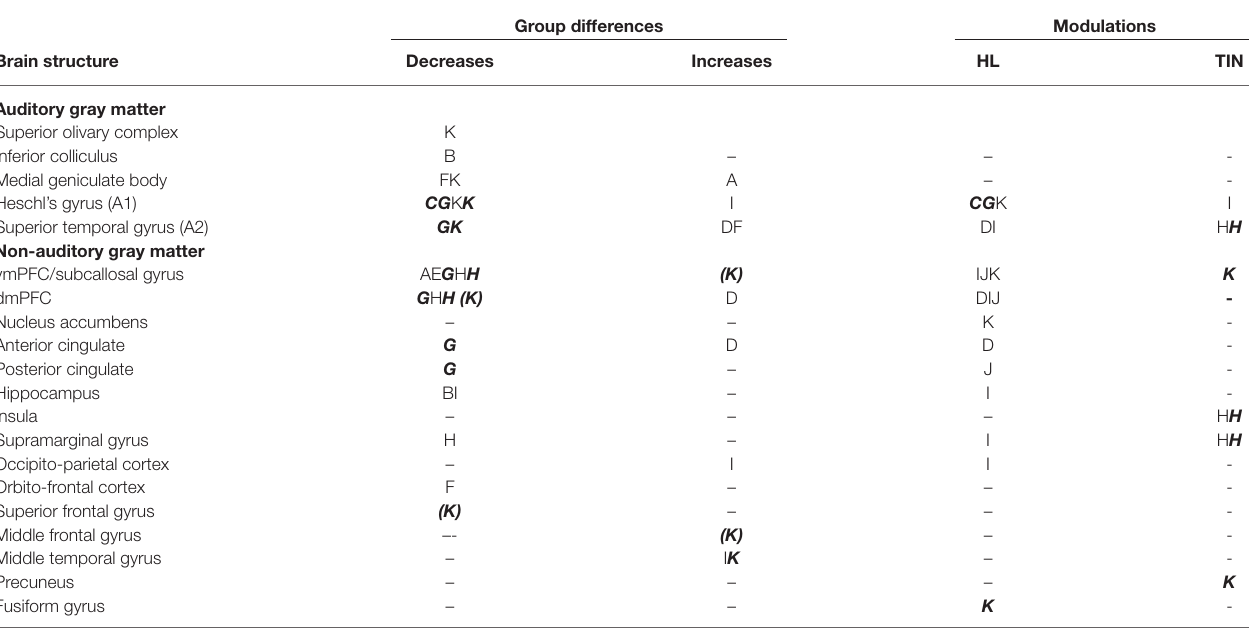
TABLE 4 | Summary of main results of previous tinnitus VBM and SBM studies compared to present results (table adapted from Adjamian et al.,